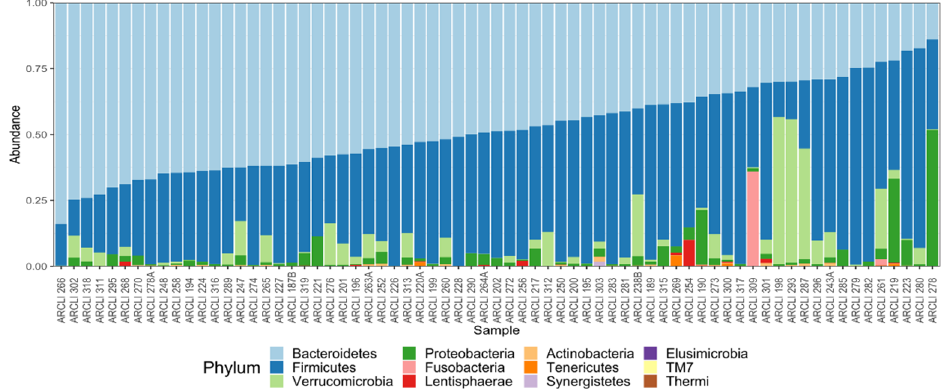
Figure 1. Bar plot of the abundance of different phyla in the cohort. The bar graph is presented as percent abundances of a total of twelve phyla for each participant. Graph is sorted based on Bacteroidetes abundance from lower to higher using the R package ‘microbiome’.